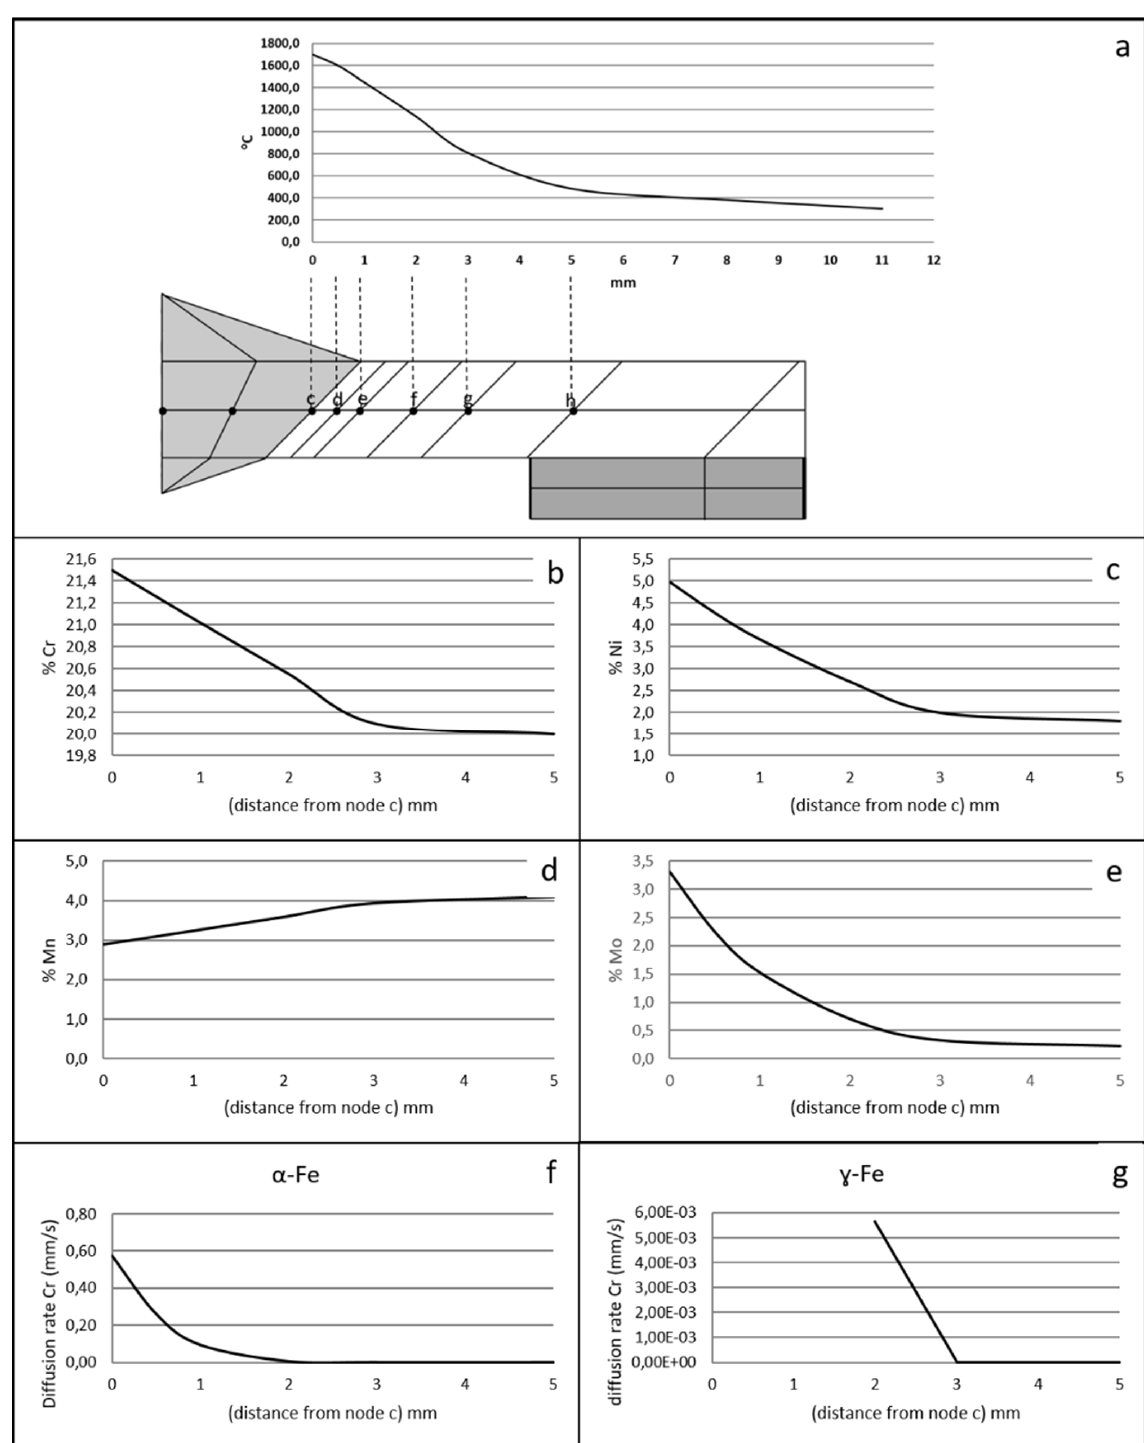
Figure 5. ( a ) Thermal cycling of the study nodes, Variation of the composition of the study nodes: ( b ) chromium, ( c ) nickel, ( d ) manganese, ( e ) molybdenum, ( f ) diffusion rate of chromium in α -Fe, ( g ) diffusion rate of chromium in ɣ -Fe.